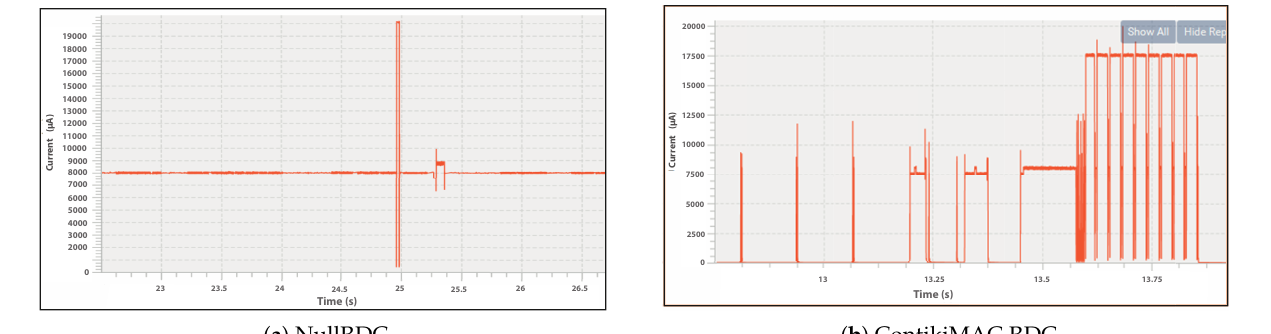
Figure 10. Power consumption of S2LP radio.